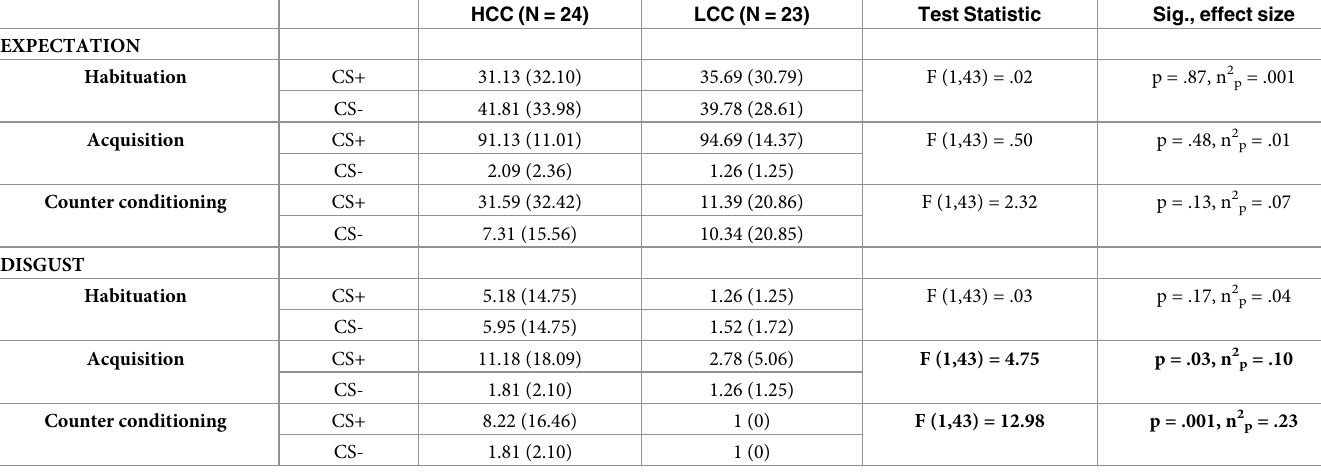
Table 2. Mean (SD), and between-group comparisons of direct evaluation on US expectation and valence ratings on empirical valence scale (100 points).